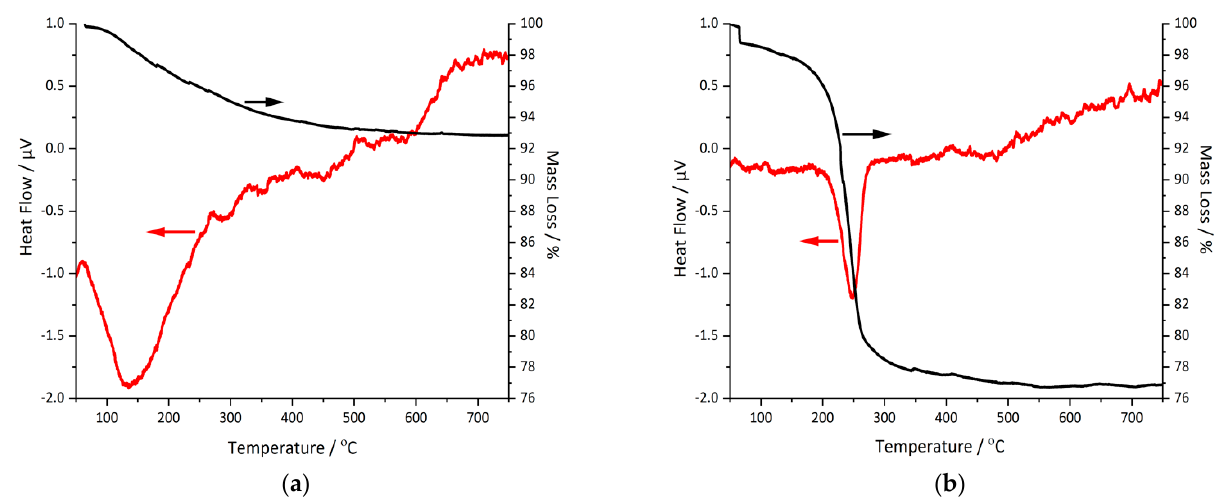
Figure 2. Thermal gravimetric and differential thermal analysis of the precipitated catalyst precursors: ( a ) d-CeO 2 (IV) and ( b ) d-CeO 2 (III). Samples heated under flowing air atmosphere from 50 to 750 °C at 5 °C min − 1 .